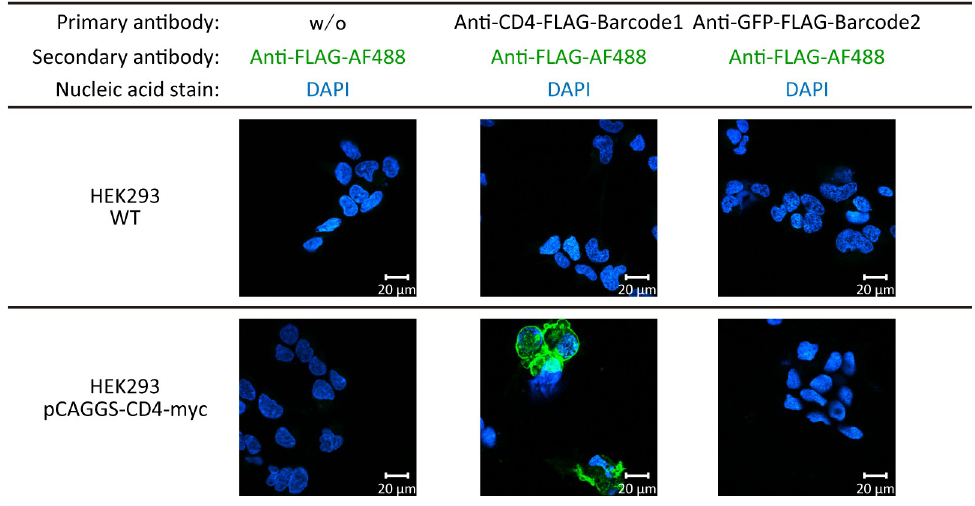
Fig 3. Immunofluorescence staining of CD4. Nuclei were stained by 4 0 ,6-diamidino-2-phenylindole (DAPI, blue). CD4 was stained by each nanobody purified with anti-FLAG gels as a primary antibody and anti-DDDDK-tag mAb Alexa Fluor 488 (anti-FLAG-AF488) as a secondary antibody (green). CD4 was specifically stained by the anti- CD4-FLAG-Barcode 1. Wild-type HEK293 cells were used as negative control cells. Scale bars indicate 20 μ m.